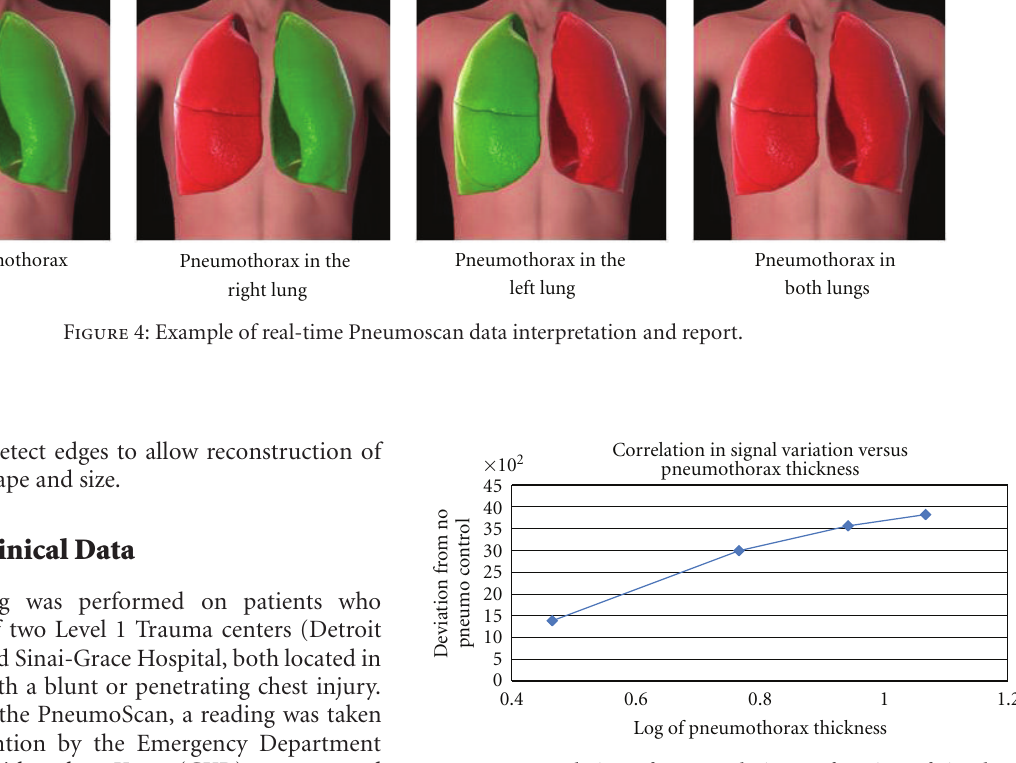
Figure 5: Correlation of scan analysis as a function of simulated pneumothorax